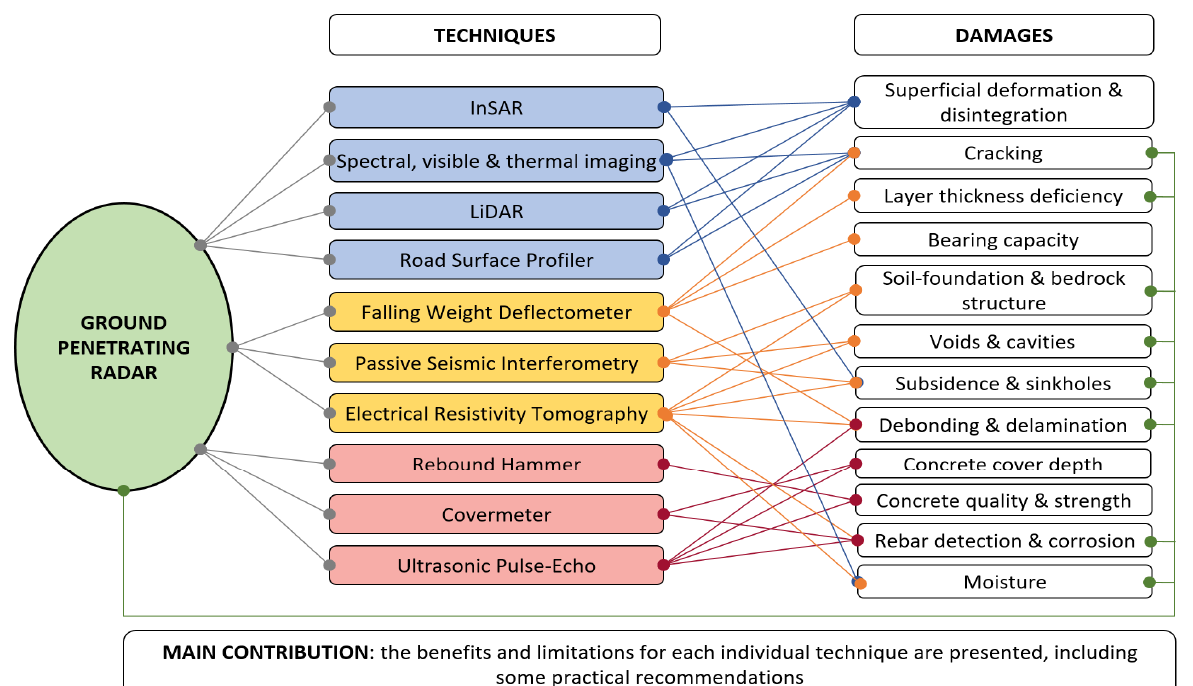
Figure 1. Main contributions of this review study (GPR combined with other NDTs and pavement damages covered).